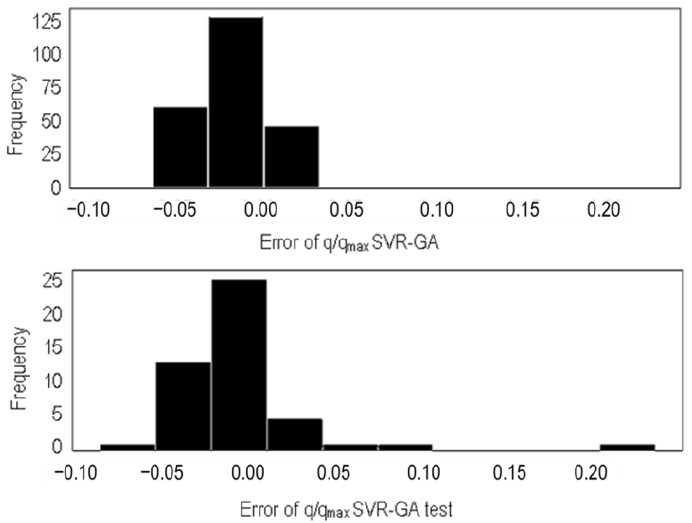
Figure 11. Error distribution for the SVR-GA model.